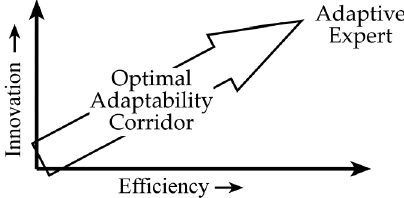
FIG. 1. Model of Schwartz et al. [15] for the roles of ‘‘efficiency’’ and ‘‘innovation’’ in